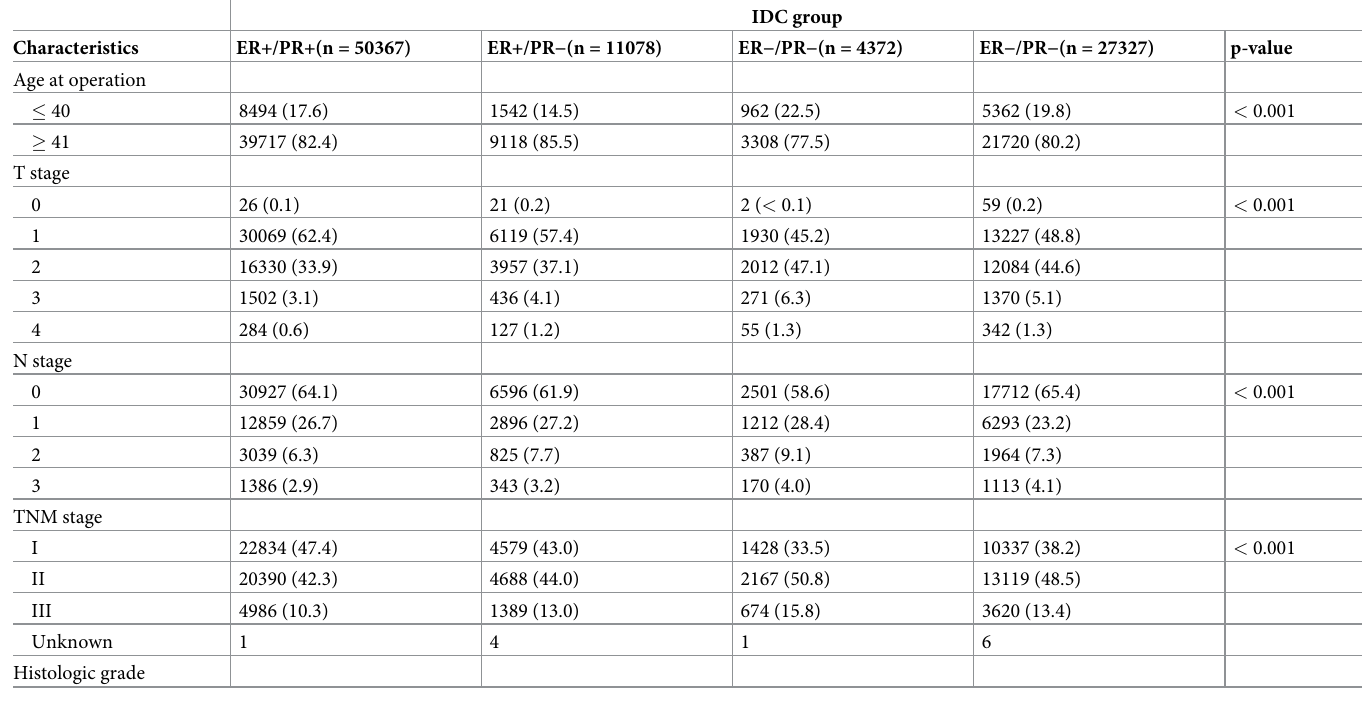
Table 2–1. Clinicopathological characteristics of hormonal expression subgroups in the IDC